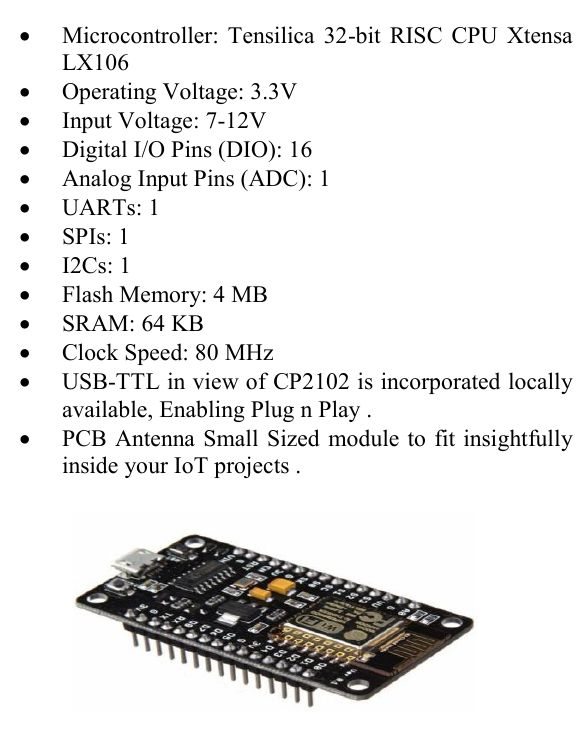
Fig 5. ESP2866 Microcontroller .